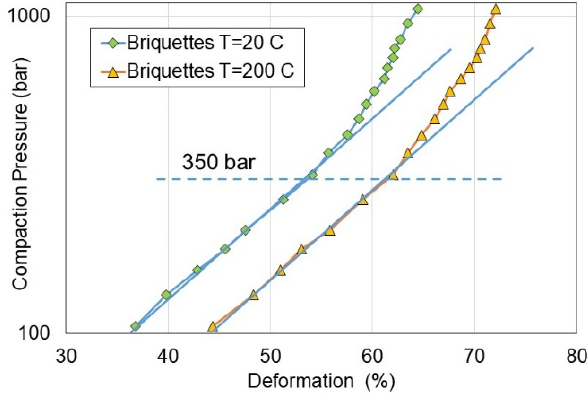
Figure 8. Compaction pressure course vs. deformation of briquettes.